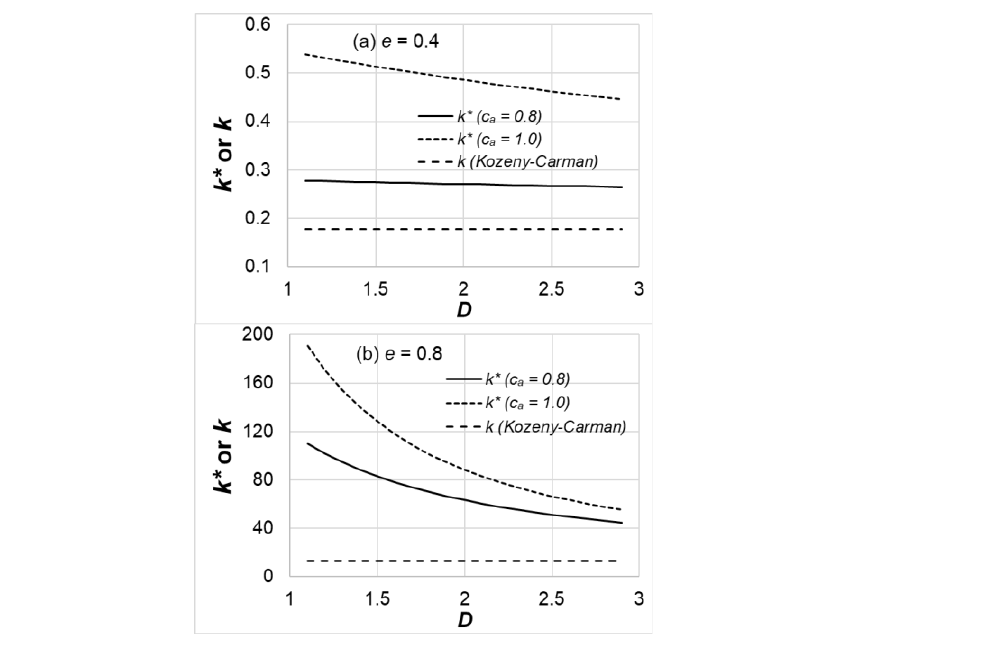
Figure 6. The influence of the fractal dimension D on the standard deviation of dimensionless per- meability s for ( a ) e = 0.4 and ( b ) e = 0.8.